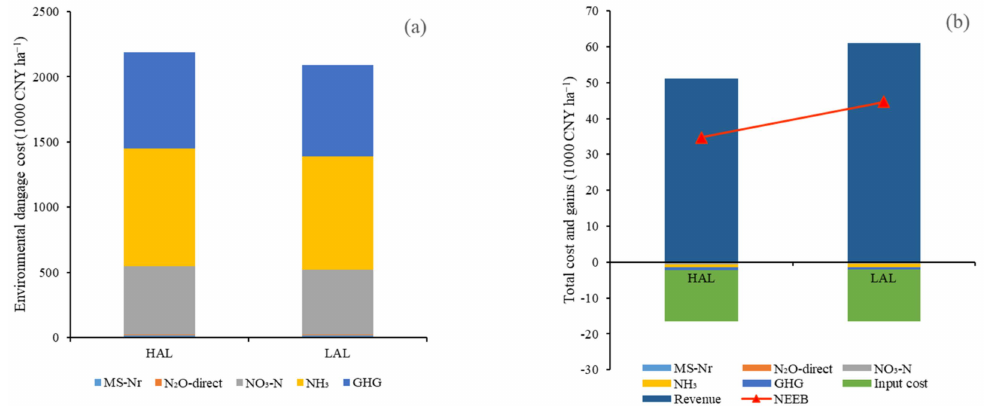
Figure 2. Environmental damage costs ( a ) and total net ecosystem economic benefits ( b ) in HAL and LAL for open-field vegetable production. HAL represents the high-altitude level (500–800 m), and LAL represents the low-altitude level (900–1200